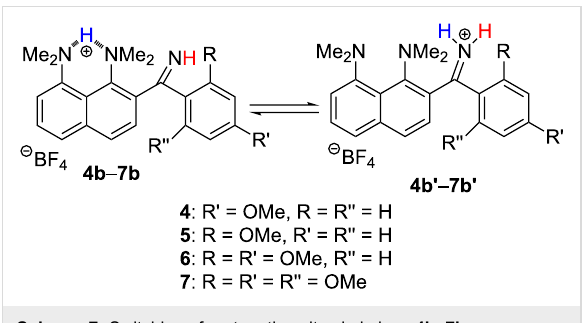
NMe 2 groups lose conjugation with the ring whereas the C=N